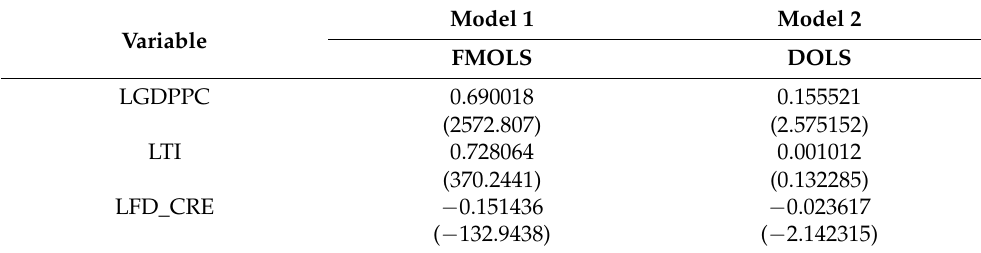
Table 6. FMOLS and DOLS estimates of the relationship between TI, FD_CRED and IE.